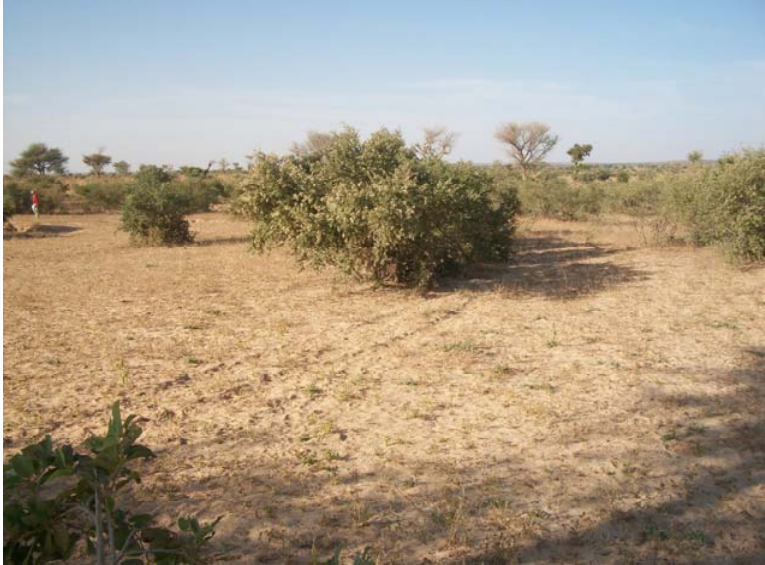
Figure 2. Surroundings of Guileyni. Shrubs ( Guiera senegalensis ) in the foreground, trees ( Faedherbia qlbida ) in the background. Photo: J.L. San Emeterio (November 2009).